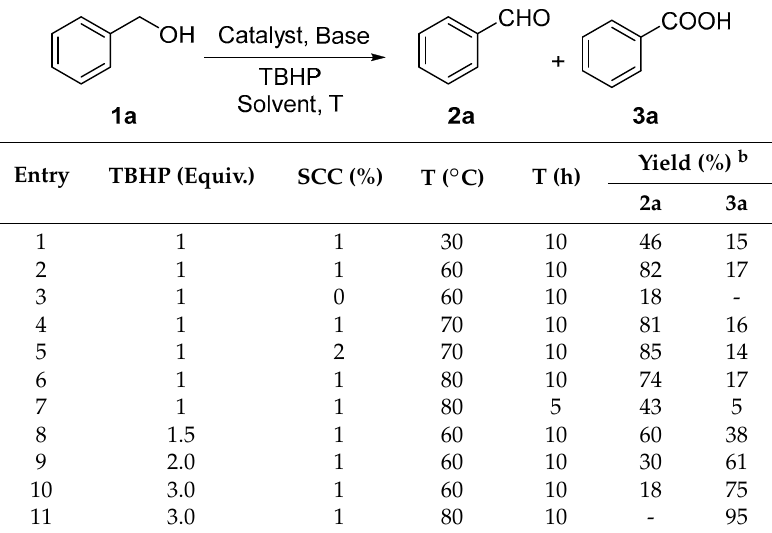
Table 1. The optimization of the oxidation reaction a .